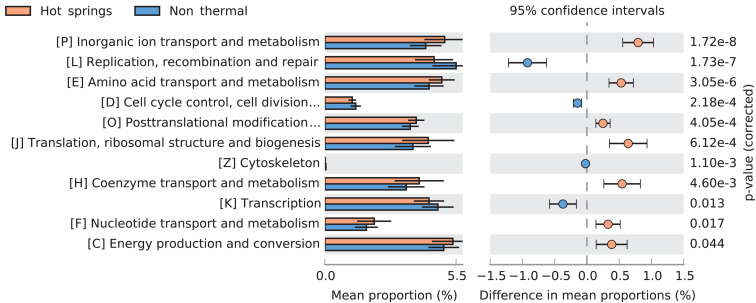
Comparison of COG categories between hot spring and non-thermal genomes. Extended error bar plot showing significantly different predicted COG categories between hot spring (n = 93) and non-thermal (n = 66) cyanobacterial genomes. Only corrected p-values < 0.05 are displayed.